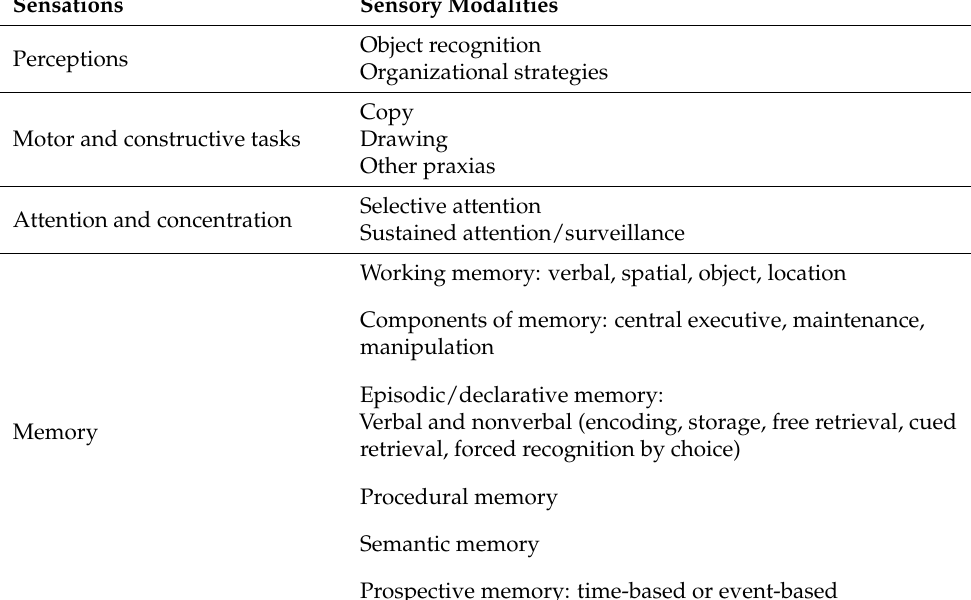
Table 2. Cognitive function